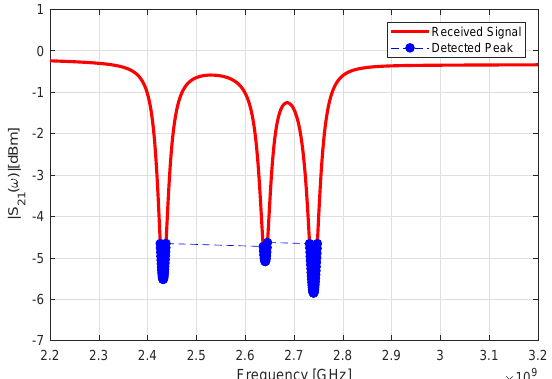
Figure 4. Numerical assessment. Peak detected with the quantile regression, tag configuration 10110.